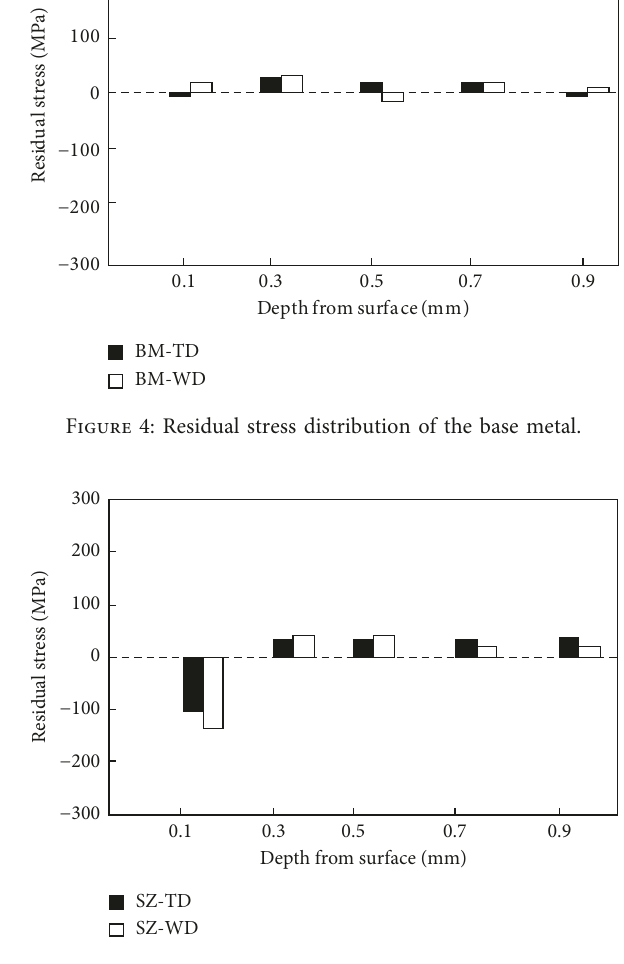
Figure 5: Residual stress distribution of the stir zone.